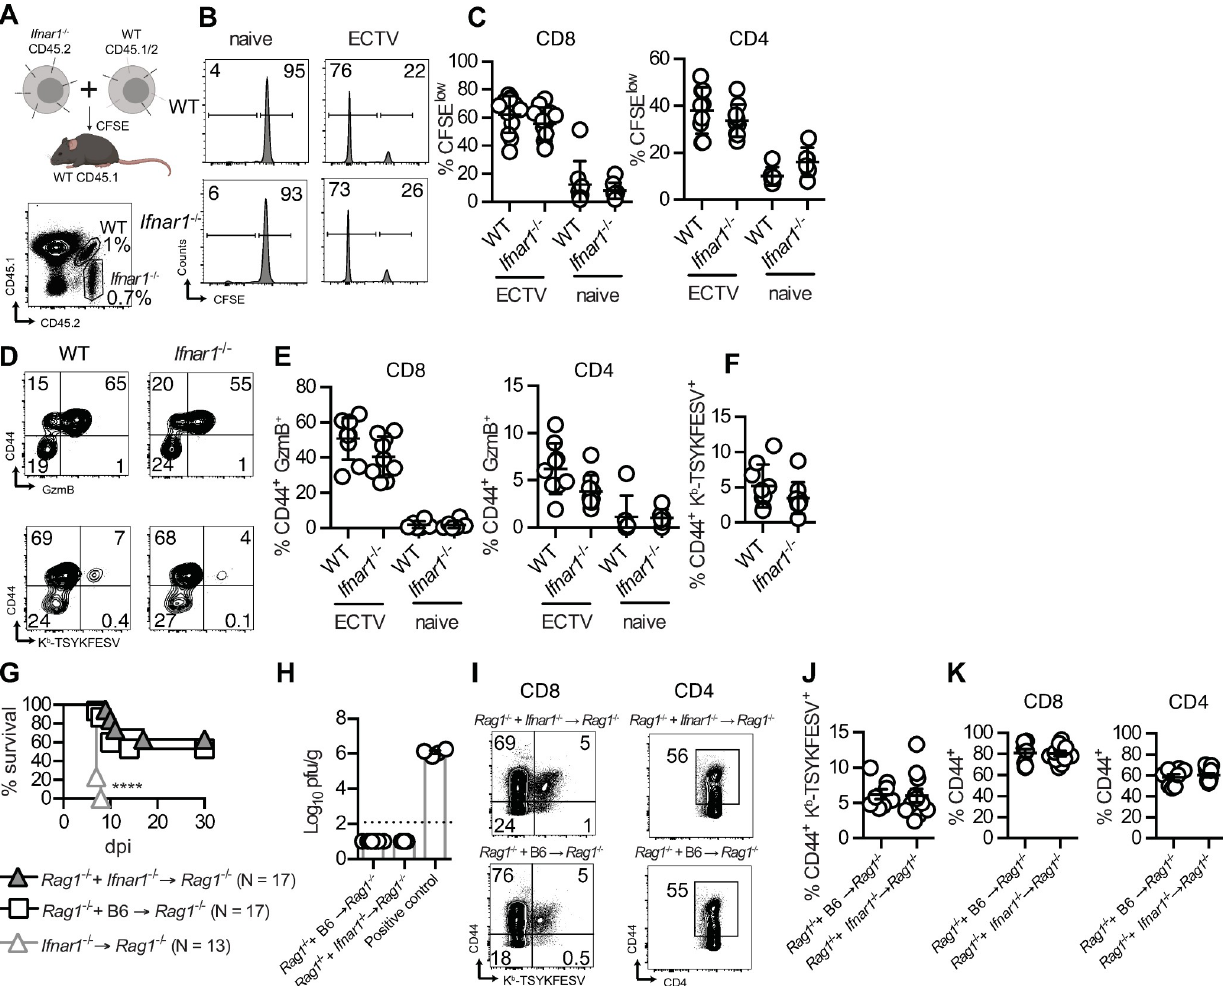
Fig 3. Intrinsic IFNAR on adaptive lymphocytes is dispensable for efficient T cell responses and resistance to mousepox. (A) CFSE-labeled WT (F1 [B6.CD45.1 x B6.CD45.2) and Ifnar1 -/- (CD45.2) splenocytes mixed in 1:1 ratio were adoptively transferred i.v. into na ï ve or infected mousepox resistant WT hosts (B6.CD45.1), and spleens were harvested at 7.5 days following ECTV infection and transfer. Created with BioRender.com. (B) Representative flow cytometry histograms of CFSE dilution in gated CD8 T cells (NK1.1 - TCR β + CD8 + ) in infected and na ï ve hosts. (C) Percentages of CFSE low CD8 and CD4 T cells (NK1.1 - TCR β + CD4 + ). (D) Representative flow cytometry plots showing staining with anti-CD44 and -GzmB (top) or anti-CD44 and K b - TSYKFESV dimers (bottom) of donor WT or Ifnar1 -/- CD8 T cells. (E) Percentages of CD44 + GzmB + CD8 and CD4 T cells. (F) Percentages of CD44 + K b - TSYKFESV + CD8 T cells. Data are represented as mean ± SEM from two pooled independent experiments (N = 9 for infected hosts and N = 6 for na ï ve hosts). (G) Survival of indicated BMC infected with 3000 pfu of ECTV-GFP in the footpad (Log-rank Mantel-Cox compared to Rag1 -/- + Ifnar1 -/- ! Rag1 -/- and to Rag1 -/- + B6 ! Rag1 -/- ). (H) ECTV viral titers in the livers of survivors at endpoint (30 dpi) quantified by plaque assay. The dashed line indicates the detection limit. Positive control: liver sample harvested from infected Ifnar1 -/- mice at 5 dpi. (I) Concatenated flow cytometry plots showing levels of K b - TSYKFESV + CD8 T cells and levels of CD44 expression in CD8 and CD4 T cells in the blood of survivor mice at 22 dpi. The graphs of the left are gated on CD8 T cells. (J) Percentages of CD44 + K b -TSYKFESV + CD8 T cells. (K) Percentages of antigen experienced CD44 + CD8 and CD4 T cells. Data are represented as mean ± SEM from three pooled independent experiments (N = 8 for Rag1 -/- + B6 ! Rag1 -/- and N = 11 for Rag1 -/- + Ifnar1 -/- ! Rag1 -/- survivors). https://doi.org/10.1371/journal.ppat.1009593.g003 Cre to NK cells and other group 1 innate lymphoid cells (ILCs). By flow cytometry, anti- IFNAR1 monoclonal antibody (mAb) stained T cells and NK cells in Ifnar1 fl/fl mice, T cells but not NK cells in Ifnar1 Δ NKp46 mice, and neither T cells nor NK cells in Ifnar1 Δ Vav1 mice ( Fig 4A ), demonstrating the NK cell-specific and widespread deficiency of IFNAR1 in Ifnar1 Δ NKp46 and Ifnar1 Δ Vav1 mice, respectively. After ECTV infection, most Ifnar1 Δ NKp46 mice succumbed to mousepox ( Fig 4B ), with a median survival time of 9.5 days, while most Ifnar1 fl/fl littermates